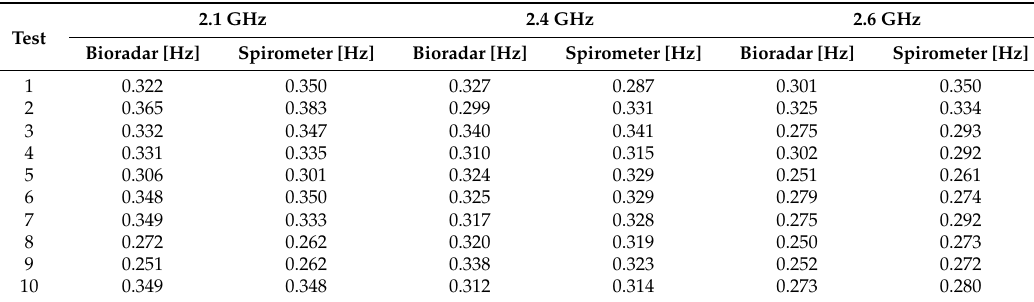
Figure 4. Comparison between bioradar and spirometer data, a one sample of test campaign for each frequency. ( a ) Comparison at 2.1 GHz; ( b ) Comparison at 2.4 GHz; ( c ) Comparison at 2.6 GHz. Table 2. Breathing rates provided by bioradar and spirometer.